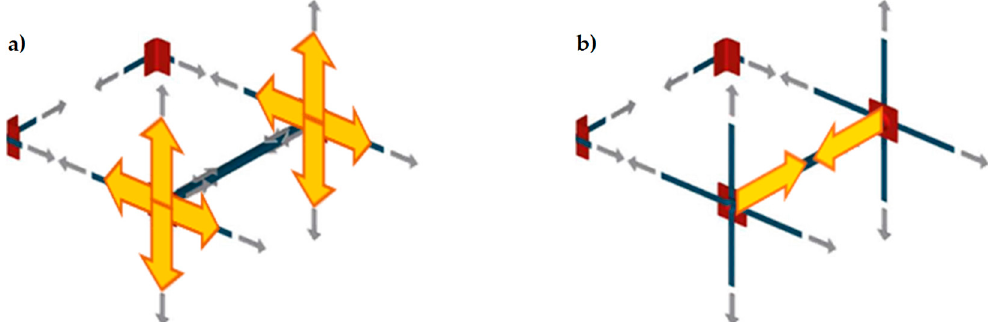
Figure 5. Forces acting on the nodes of the CAM system: ( a ) nodal forces in the plane of the wall and ( b ) Nodal forces along the wall thickness. Materials 2019 , 12 , x FOR PEER REVIEW